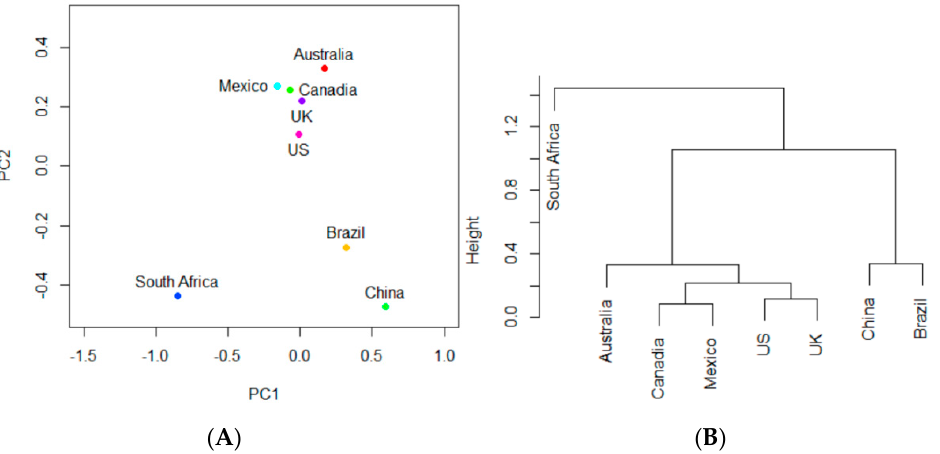
Figure 6. ( A ) Projections of South Africa, Mexico, Canada, the UK, the US, Brazil, China, and Australia onto the PC1-PC2 space based on the occurrence of AMR genes shown in Table 1; ( B ) clustering the countries based on their projections in ( A ). Int. J. Environ. Res. Public Health 2020 , 17 , 472